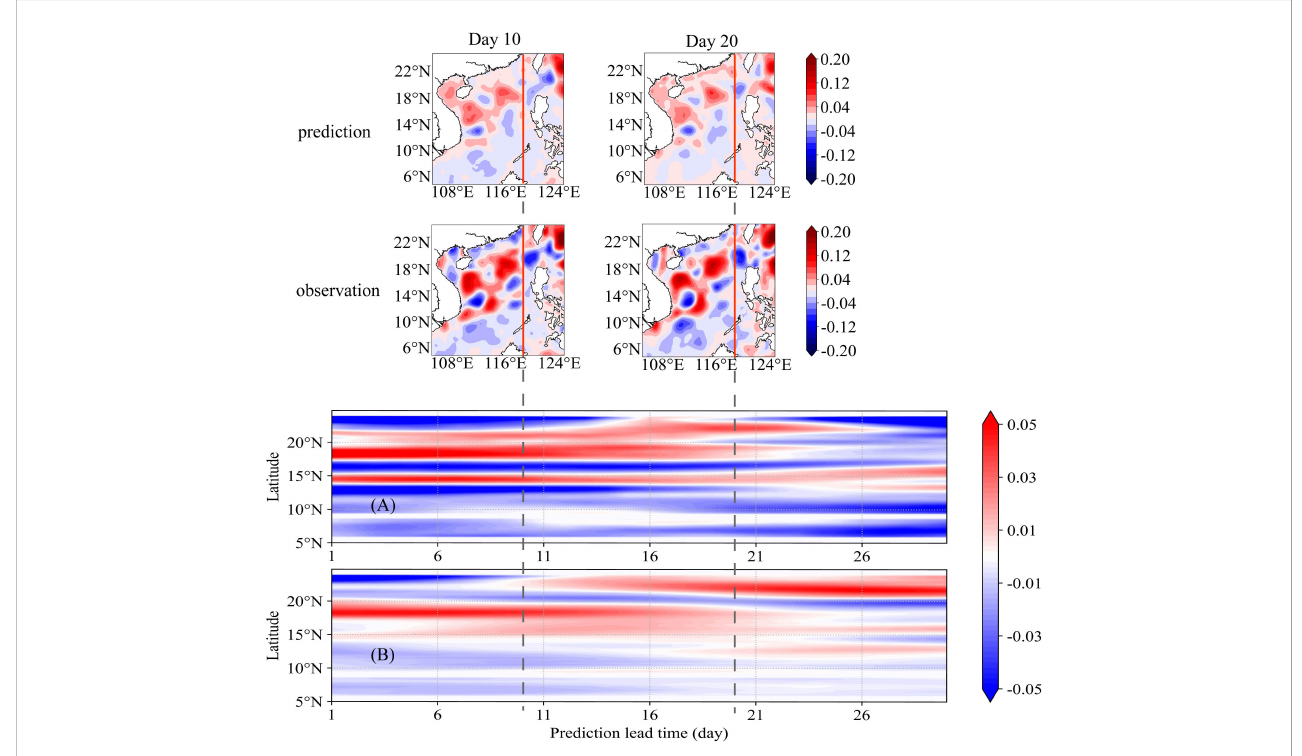
FIGURE 10 Latitude-time maps at the 118°E section. (A) observation, (B) prediction. The red solid line is the latitude range (5°N-24.75°N) of the